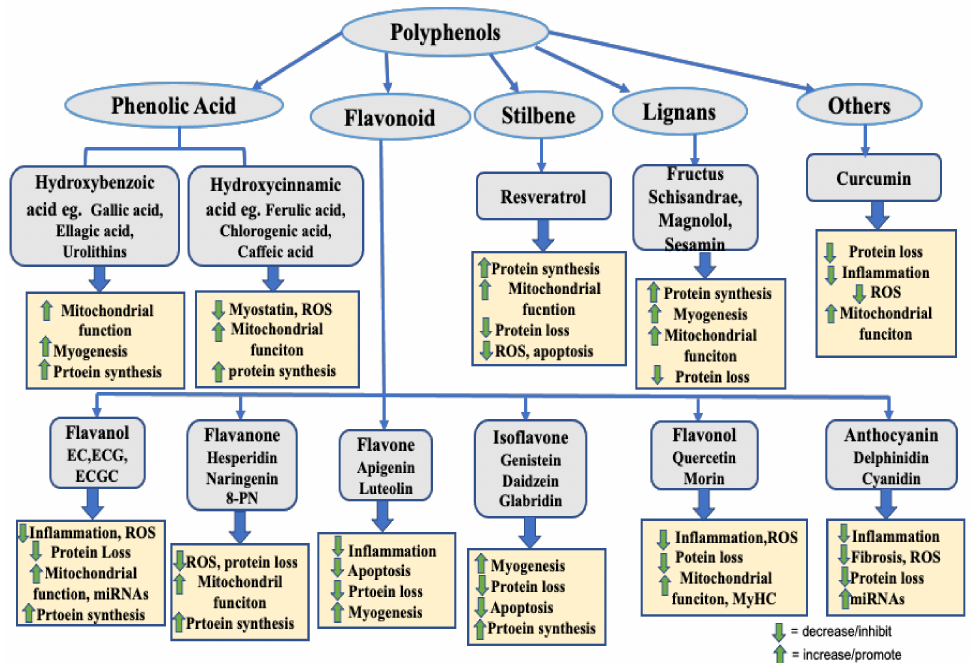
Figure 3. Schematic illustration showing members of polyphenols representative with impact on skeletal